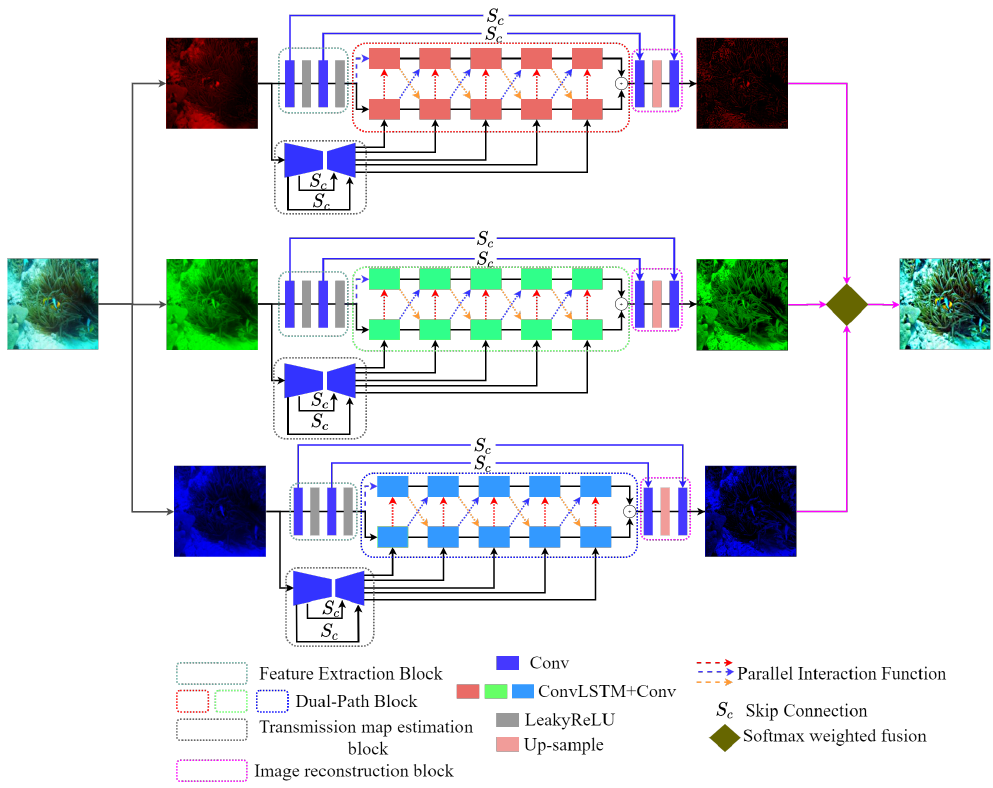
Figure 3. The proposed overall architecture of TDPRN. Feature maps are extracted via the feature extraction and transmission map estimation blocks. These blocks also estimate the transmission map for the dual-path block. Within the dual-path block, the top sequential units constitute a branch Path Λ c , and the bottom units constitute the other branch Path Λ c . These two paths interact with feature 2 1 maps through the parallel interaction function until the final stage. The image reconstruction block is used to reconstruct the corresponding color channel’s dehazed images. The color channels are then fused via the softmax-weighted stack to obtain the final dehazed